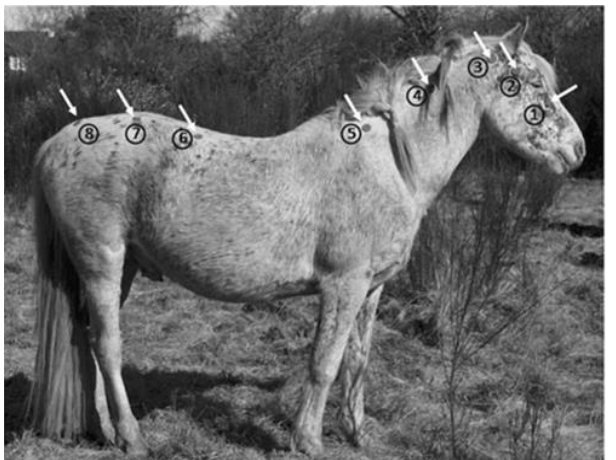
Figure 4. The eight landmarks positions. Landmarks were stuck onto the horse’s right side and placed in relation to skeletal or muscular cues on: the nasal bone under the eye, 2 cm in front of the zygomatic process (landmark 1); the temporo-maxillary joint (2); the atlas (3); the trapezium cervical ligament (4); the cervico-thoracic (5); the thoracolumbar (6); and the lumbo-sacral (7) junctions and the first coccygeal vertebra; (8). From Fureix et al. (2011), Naturwissenschaften.